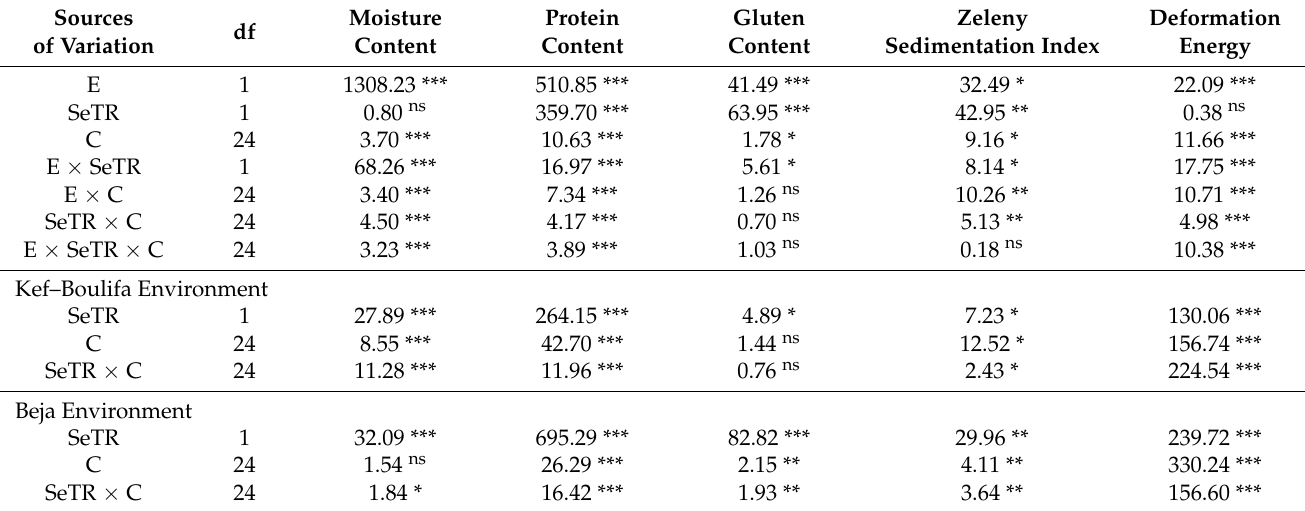
Table 3. Analysis of variance ( F values) for grain quality attributes of 25 durum wheat cultivars across the two